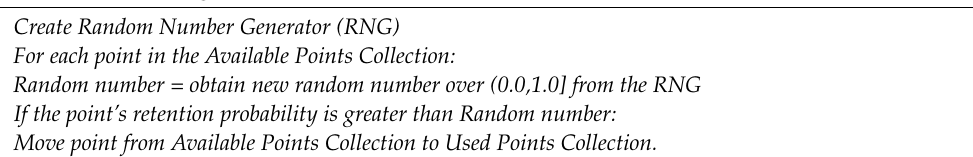
Listing 5. Pseudocode showing the process of selecting points using the Sparsity Weighted Curvature Score